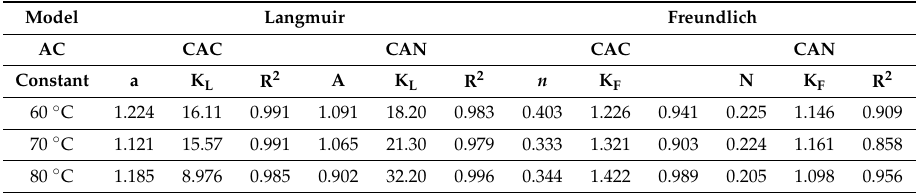
Table 3. Model Constants and R 2 values for the Langmuir and Freundlich